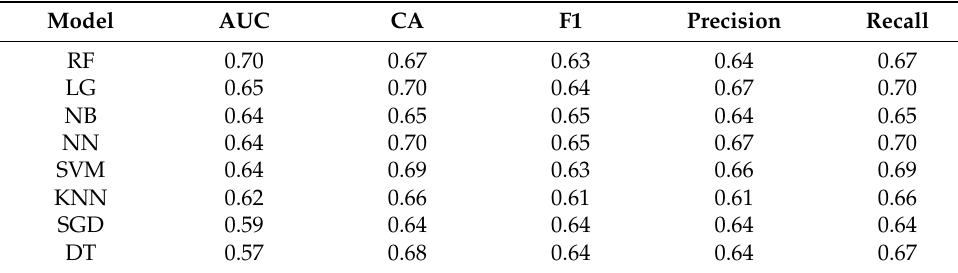
Table 1. Evaluation results of models based on different